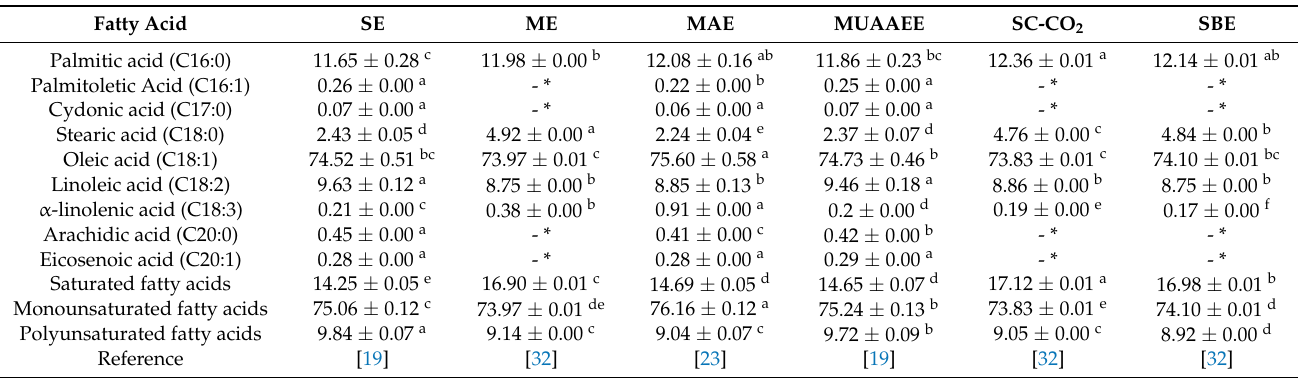
Table 2. Fatty acid composition of tiger nut oil under different extraction